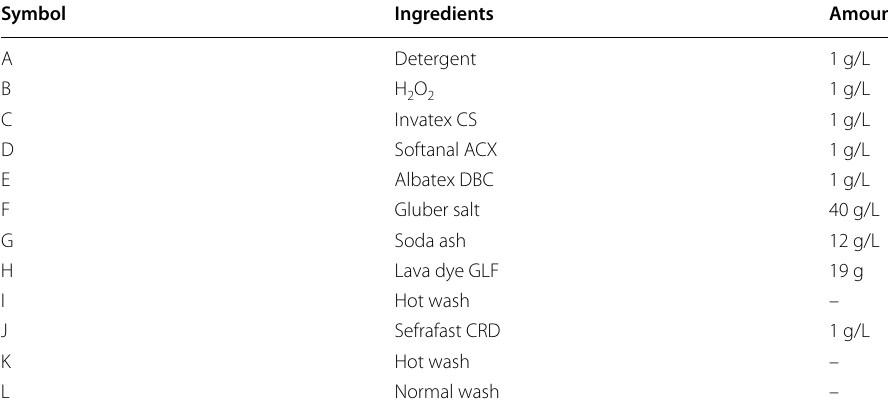
Table 1 Recipe for dischargeable reactive dye